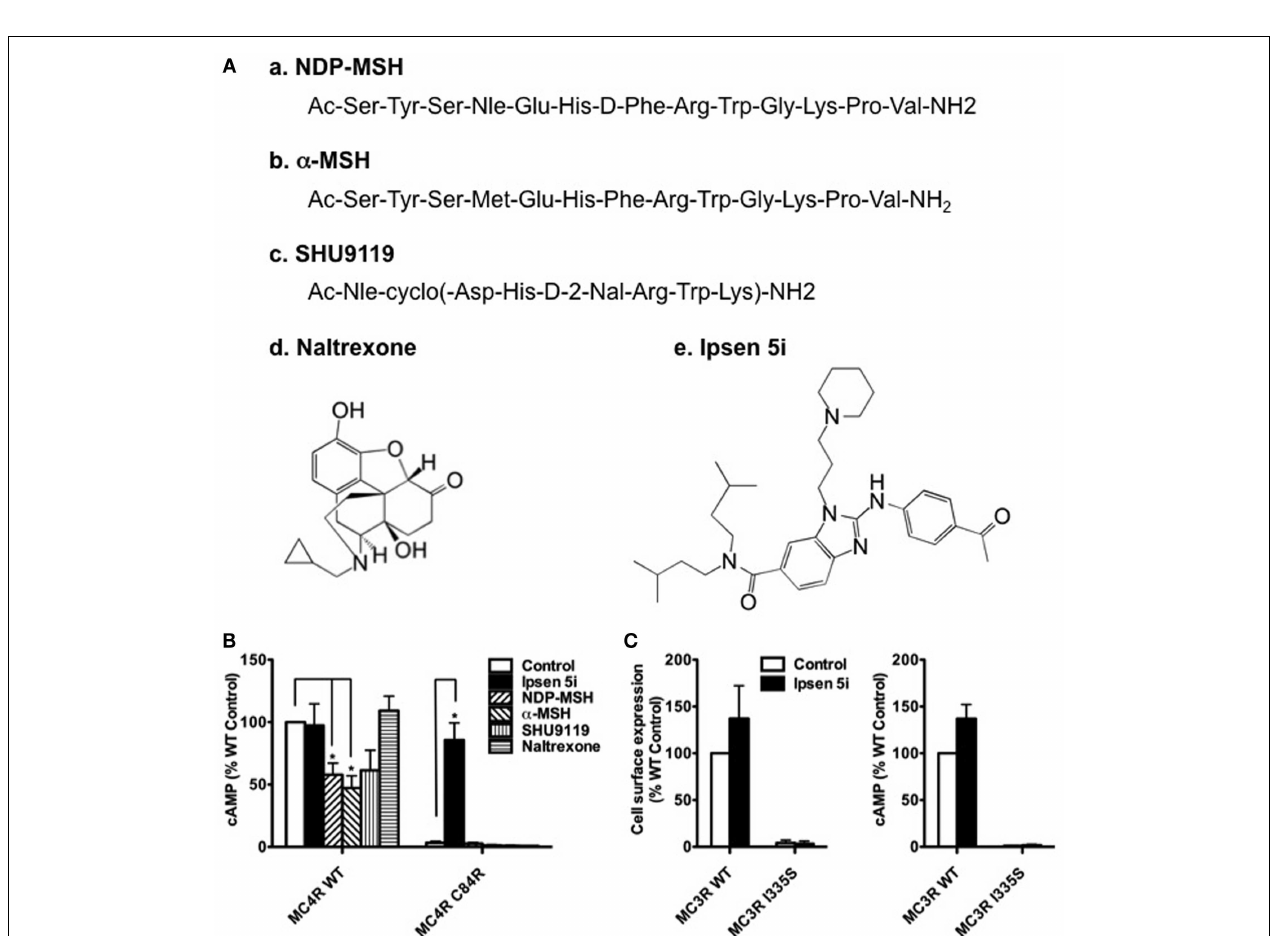
naltrexone or 10 − 6 M Ipsen 5i). Cells were washed twice and then stimulated with 10 − 6 M NDP-MSH for 1h and intracellular cAMP concentrations were measured. (C) Neuro2a cells transiently expressingWT or I335S MC3Rs were treated with 10 − 6 M Ipsen 5i for 24h.Then, the cell surface expression and intracellular cAMP production of MC3Rs were measured. Results are shown as mean ± SEM of at least three independent experiments. *Significantly different from the DMSO-treated control group, p <